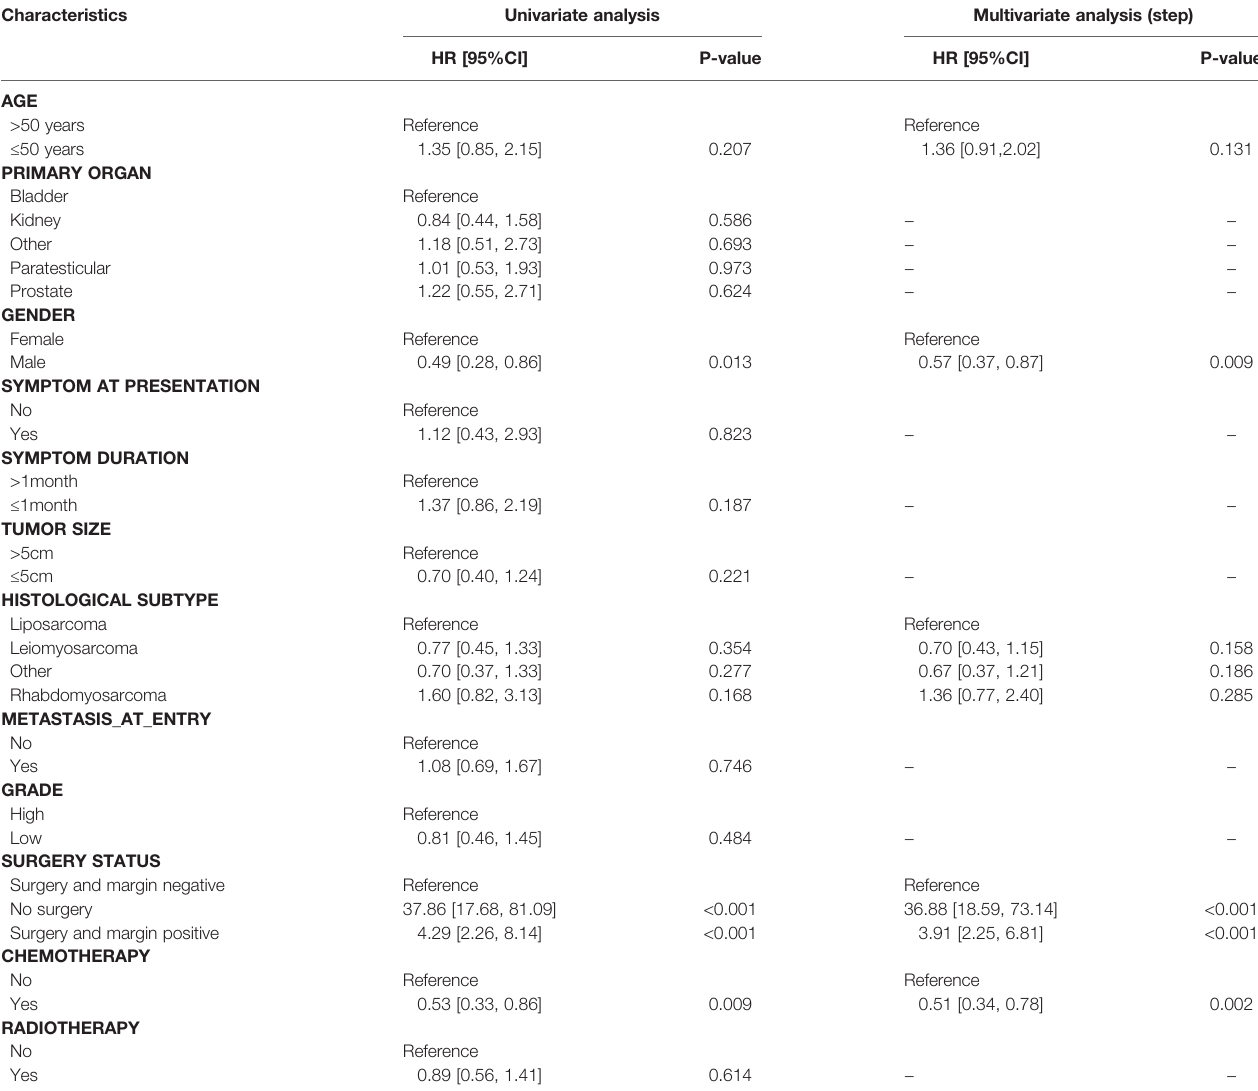
TABLE 2 | Univariate and multivariate analyses of overall survival in the present